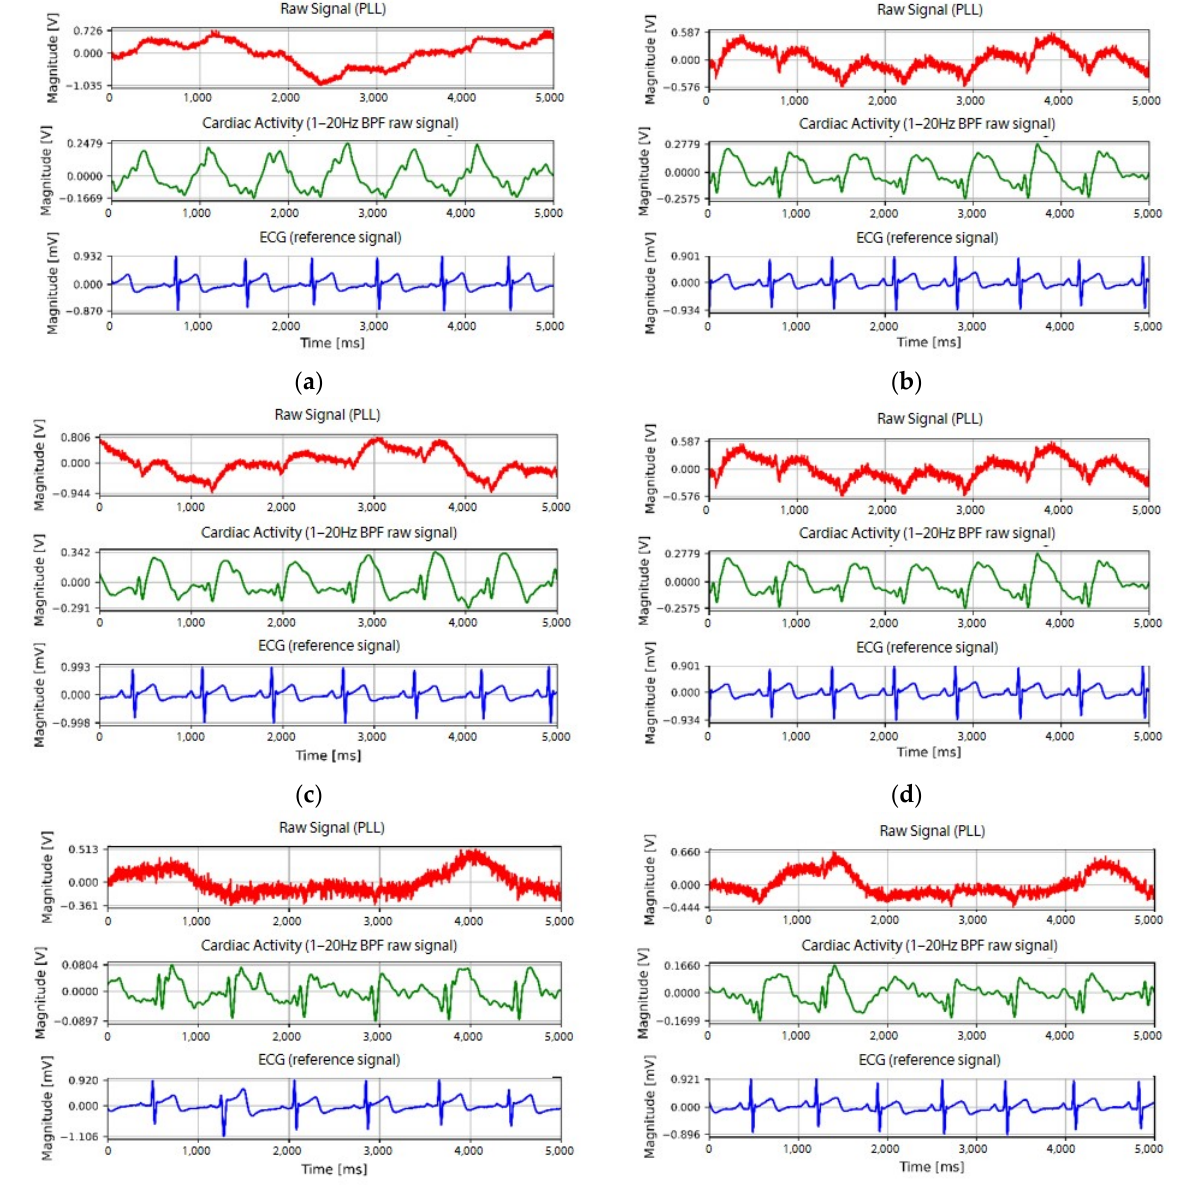
Figure 7. Cardiac activity signals according to the shape and measurement position of the fabric loop sensor: spiral loop sensor at ( a ) P2, ( b ) P4, and ( c ) P6; ( d ) spiral, ( e ) extrusion, and ( f ) spiky loop sensors at P4.